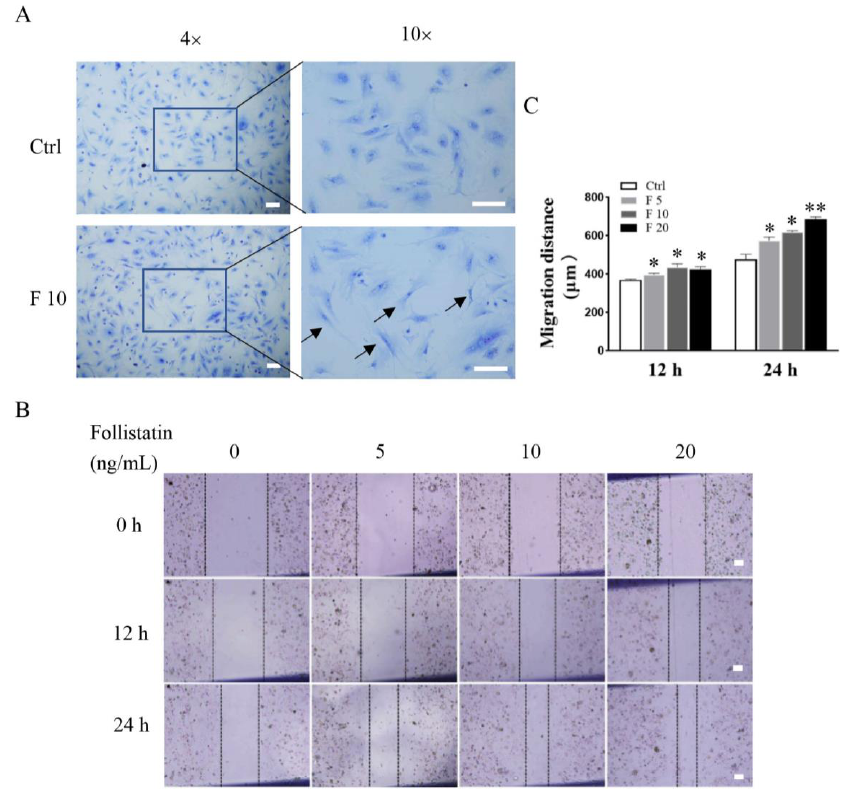
Figure 3. Effects of FST on morphology and wound healing of primary cultured trophoblasts of mice. ( A ) Morphology of mice trophoblasts were determined by Giemsa staining. Arrows indicated the typical morphological changes of cells treated with 10 ng/mL FST for 24 h. ( B ) The scratch-wound model was generated in monolayer trophoblasts, and then cells were treated with FST for 12 h and 24 h, respectively. ( C ) The graph showed the degree of wound healing ( n = 3). Scale bar = 100 µ m. Ctrl: 2% FBS culture medium control. F5: 5 ng/mL of FST. F10: 10 ng/mL of FST. F20: 20 ng/mL of FST. * p < 0.05. ** p < 0.01, compared with